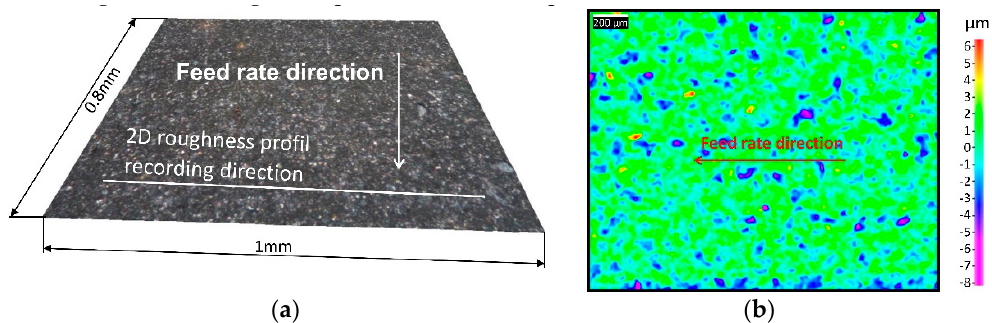
Figure 4. ENLY couple surface topology at a feed rate of 2000 mm/min. ( a ) 3D surface topology. ( b ) 3D surface roughness map.